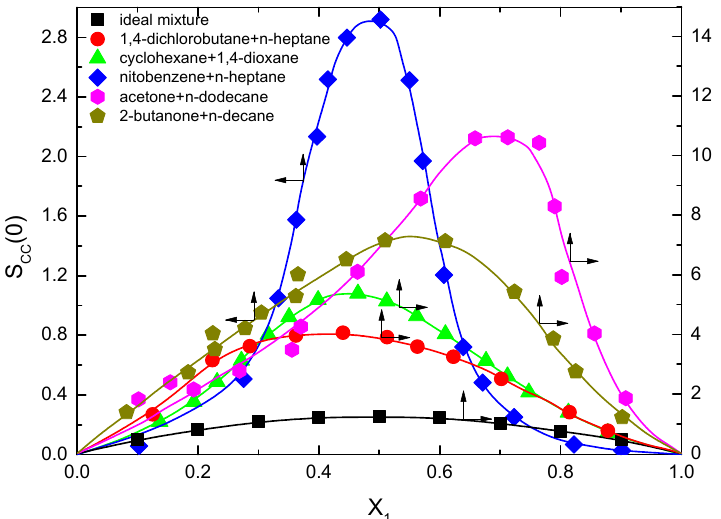
Figure 2. Composition dependence of the concentration-concentration correlation function at 298.15 K. The dashed-dotted line corresponds to an ideal mixture. Notice that some of the curves refer to the left ordinate axis, while the others refer to the right axis. Some of the data shown have been reproduced with permission from our previous publication [5].